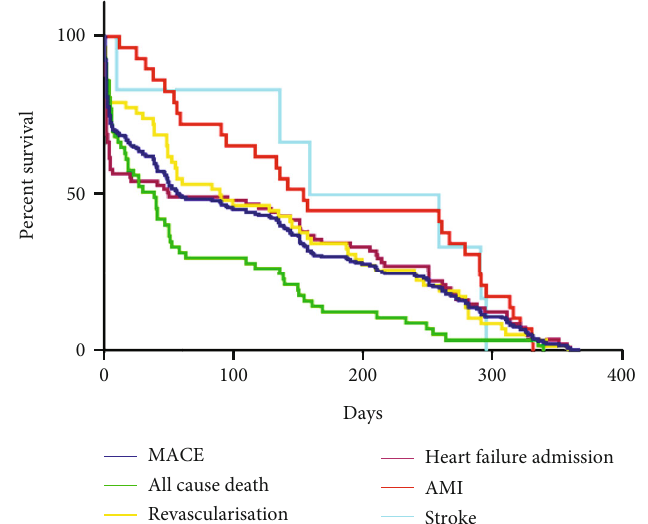
Figure 1: Kaplan-Meier survival curves of NSTEMI cohort 1-year and all-cause death, TLR, recurrent nonfatal AMI, severe HF requiring hospitalization, stroke, and MACE events (two